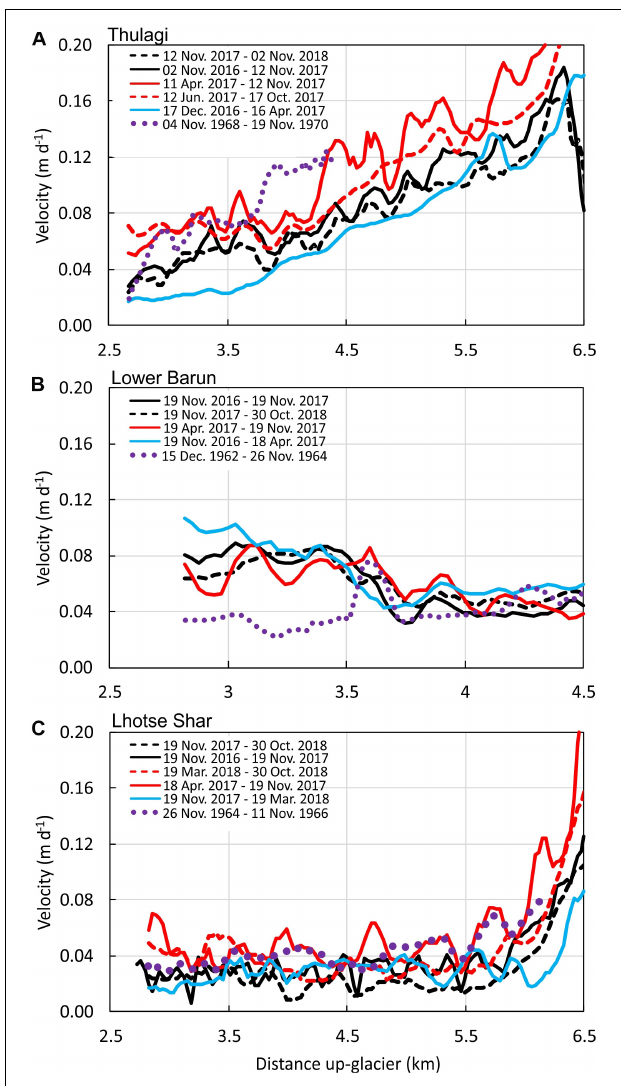
FIGURE 7 | Centreline glacier velocity for (A) Thulagi, (B) Lower Barun and (C) Lhotse Shar glaciers. Data are 150 m moving averages. Velocities for annual image pairs are coloured back, those spanning the melt season are red, those spanning winter are blue and those from Corona imagery (1960s) are dotted purple. Distances up-glacier are measured from the lake terminus corresponding to Figure 6